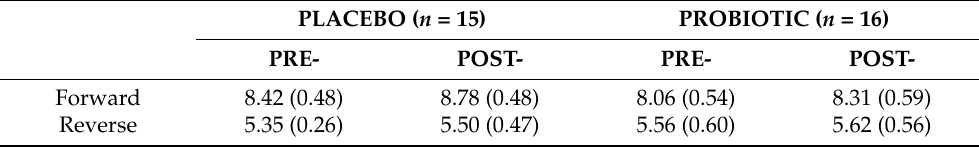
Table 2. Span of memory expressed by mean and standard